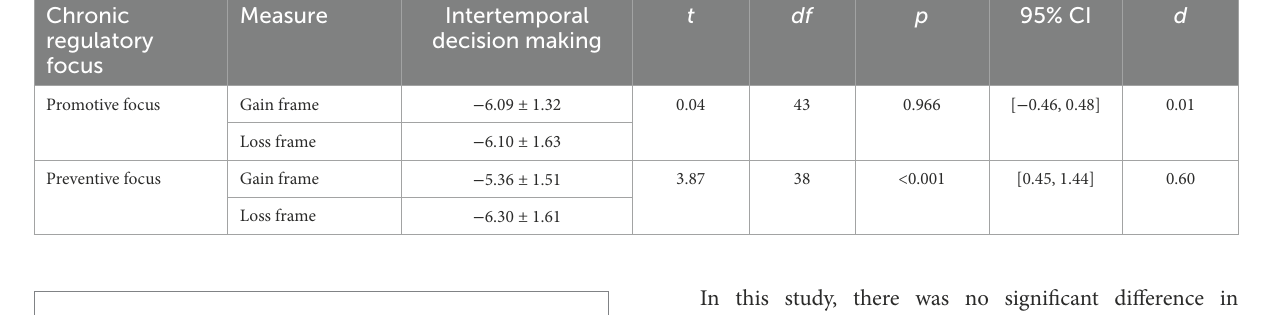
TABLE 1 An paired sample t -test for intertemporal decision making between promotive focus and preventive focus. Chronic